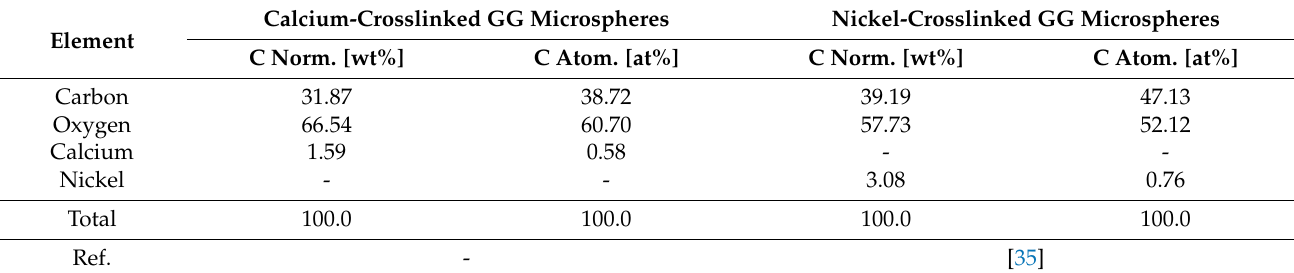
Table 1. Elemental composition of GG microspheres through